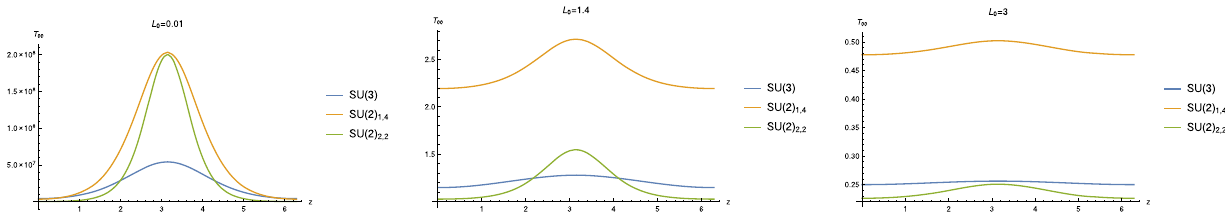
Fig. 1 Energy densities for different values of L 0 . We can see that at high Baryon density it is convenient that the 4-Baryon is “less localized” around its maximum, and at low Baryon density the energy density for both types of solutions tend to